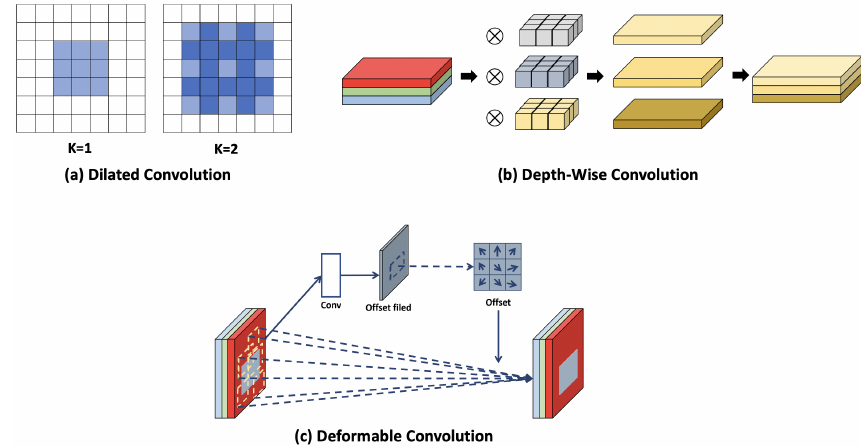
Figure 2. Structure of different convolution methods. Each convolution is a convolution that performs specialized operations to extract spatial information and geometric features, although the feature extraction performance is lower than that of the